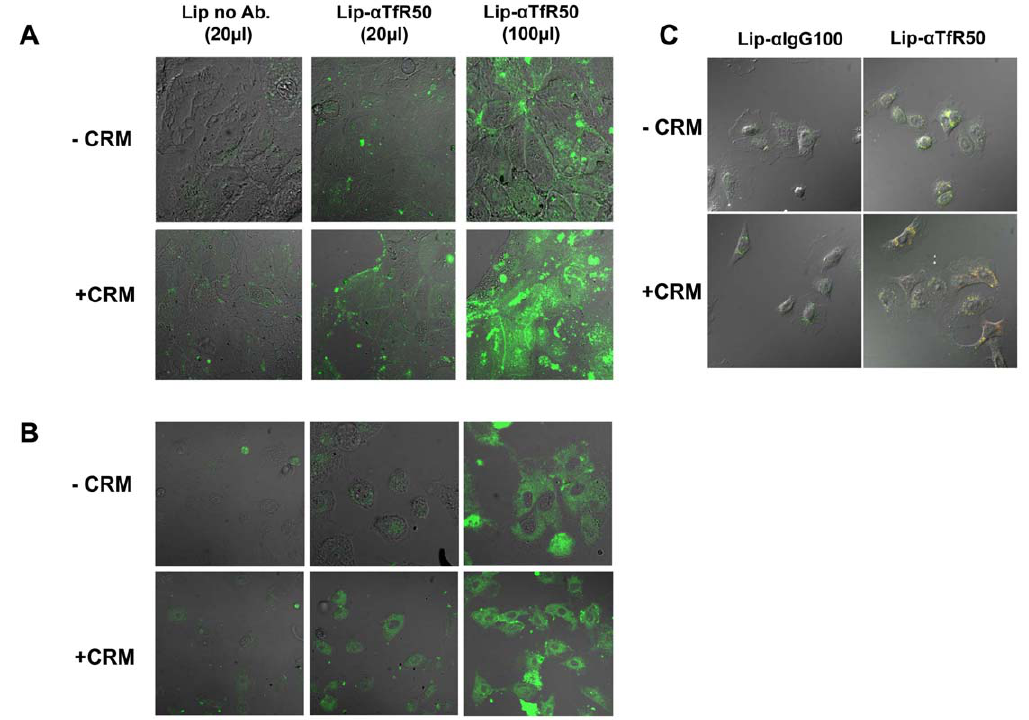
Figure 9. Cytokine treated CaCo-2 cells uptake better the immunoliposomes than naked liposomes. Representative images of confocal scan microscopy of fluorescently-tagged immunoliposomes conjugated to anti-TfR Ab (center and right panels) or naked (no Ab) negative liposomes (left panel) after 24 h of incubation with non stimulated (upper panels) or pre-incubated (lower panels) with CRM. Caco-2 cells are in panel A; IEC-6 cell are in panel B. Epifluorescence images following 10 h incubation of Lip- a IgG or Lip- a TfR in the presence or absence of CRM (C).